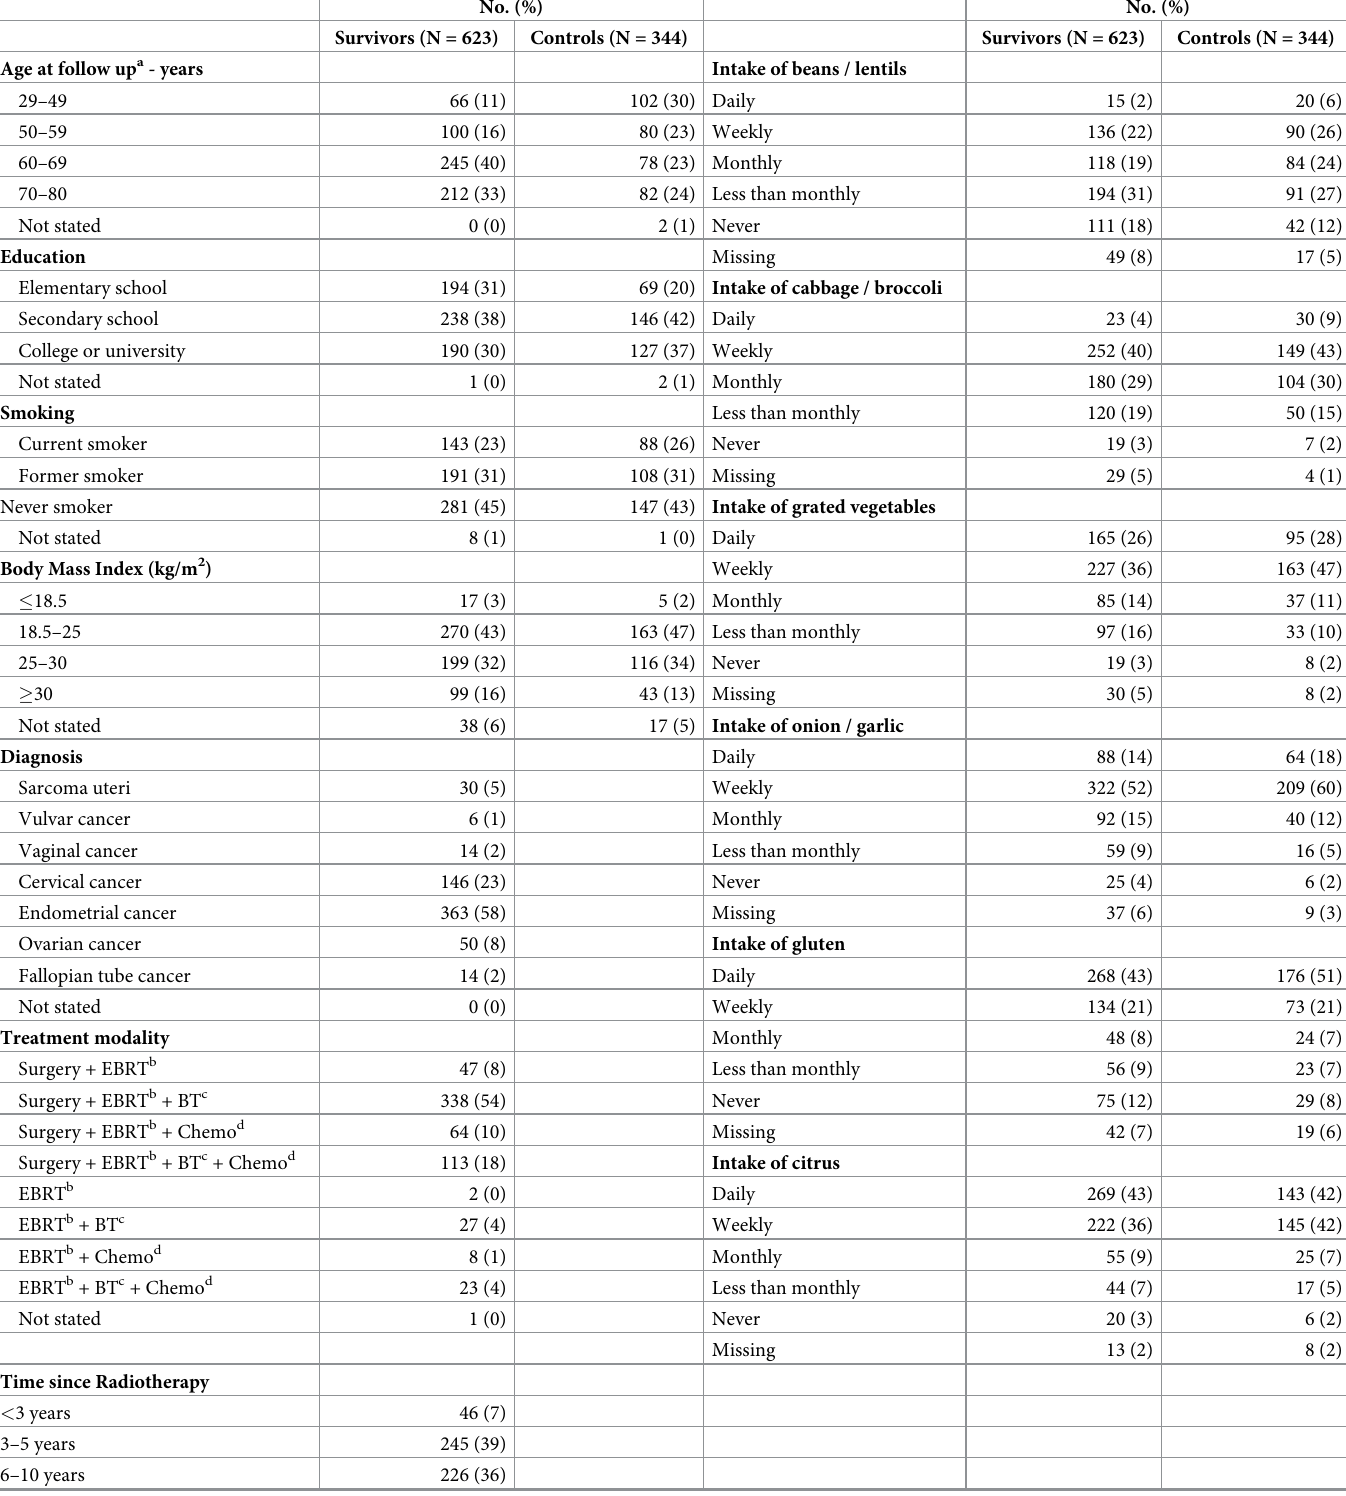
Table 1. Demographic and clinical characteristics, and dietary intake in gynecological cancer survivors and